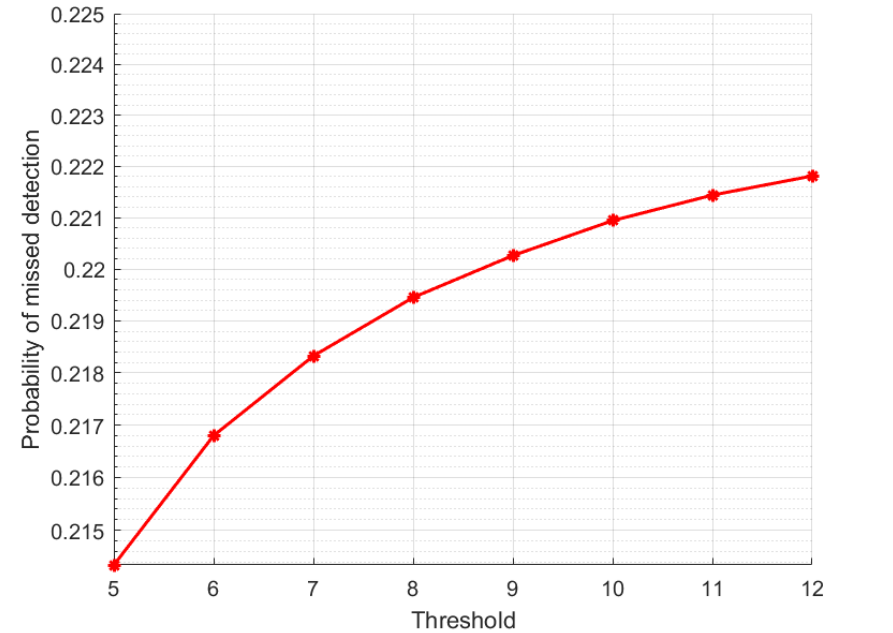
Figure 22. Probability of missed detection in ROAD statistics-based sensing (SNR = 5 dB) vs.